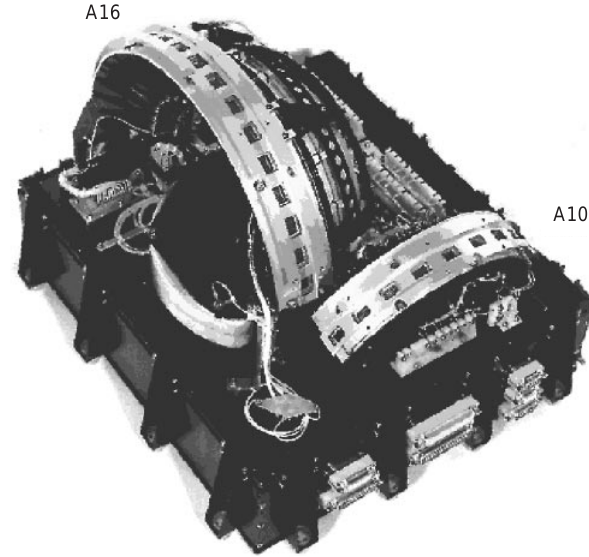
Fig. 1. Photograph of Hyperboloid without its external cover